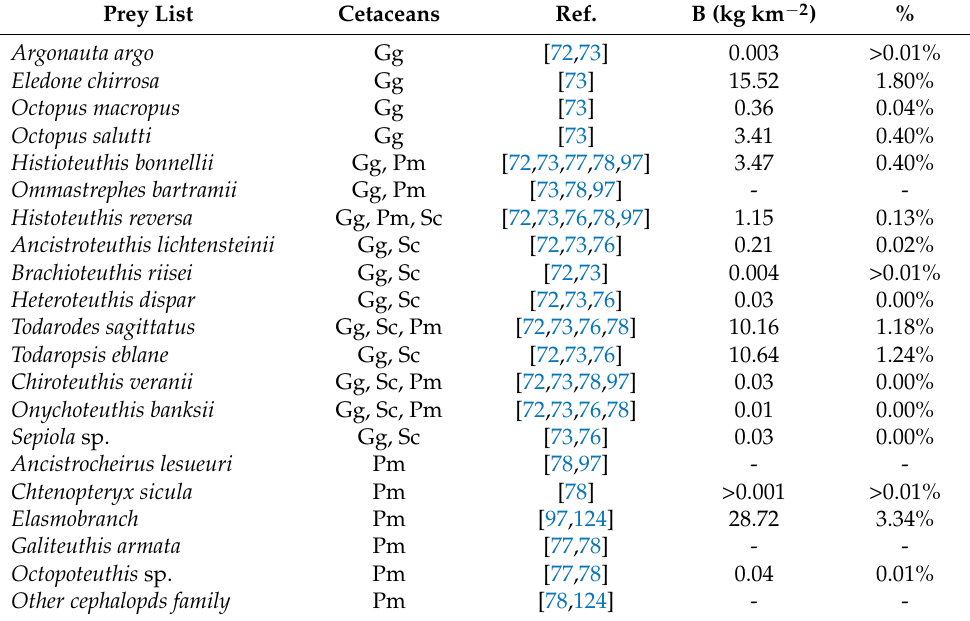
Table A1. Prey consumed by odontocetes (Pm = P. macrocephalus ; Gg = G. griseus ; Sc = S. coeruleoalba